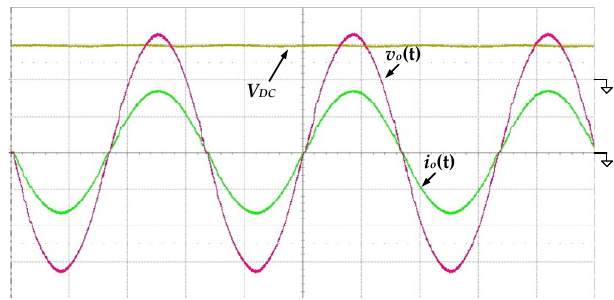
voltage, the time interval becomes longer for the step-down mode and shorter for the step-up mode.